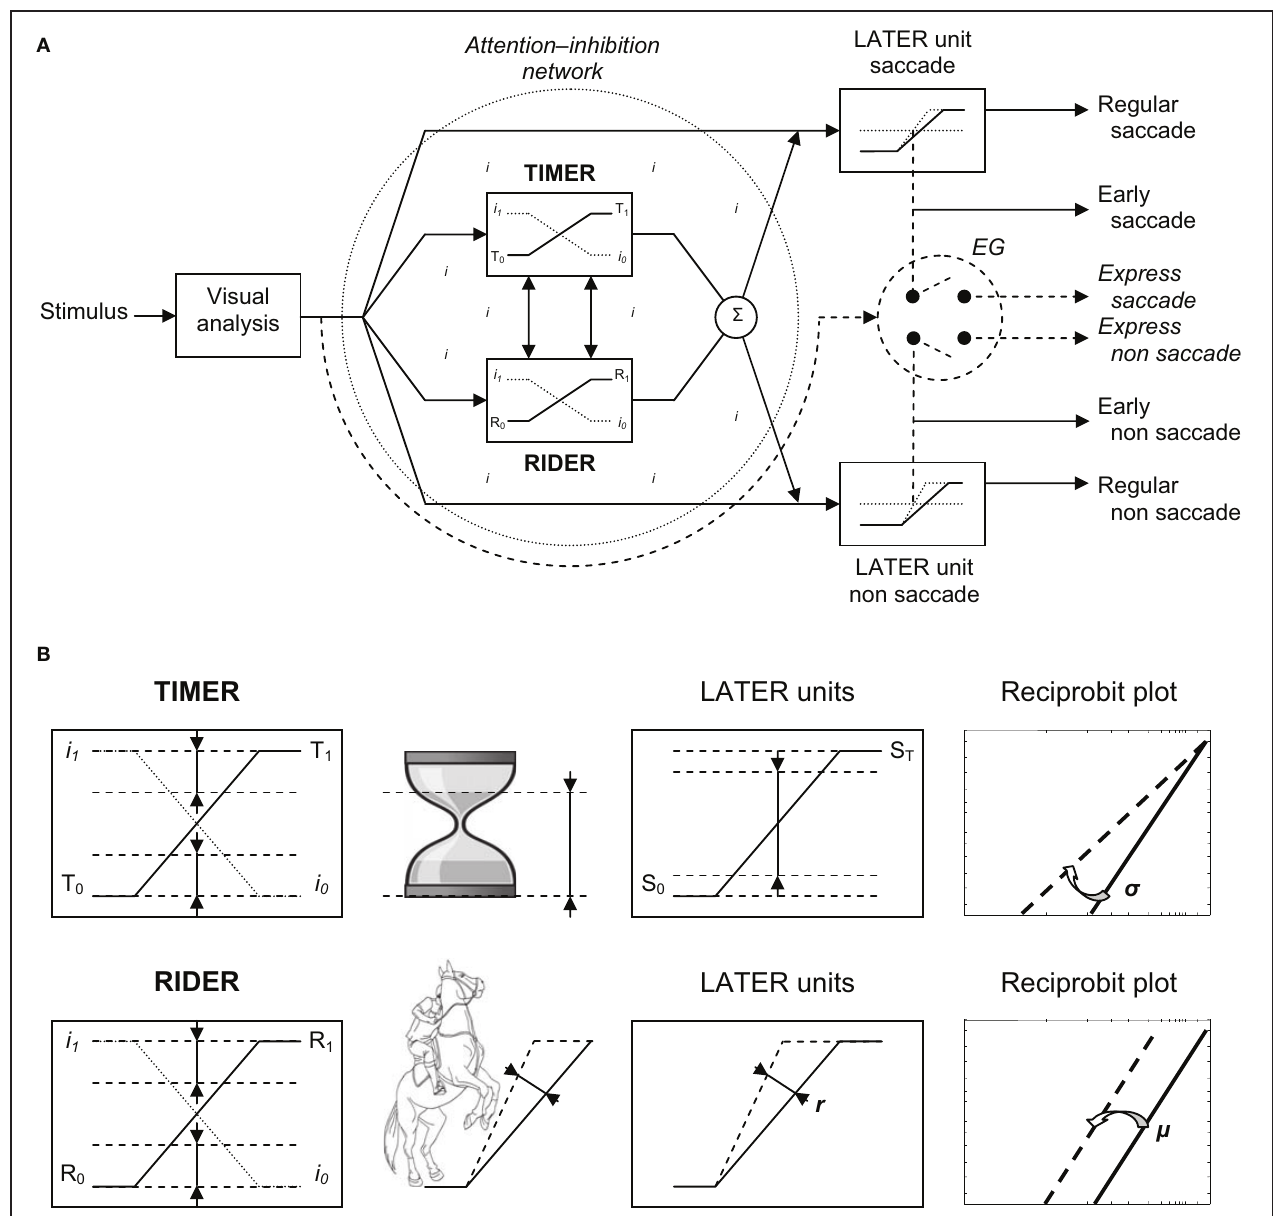
FIGURE 6 | (A) TIMER-RIDER model. Visual information from the two retinas is analyzed to determine the location of the stimulus in space. Movement activation (right): For the decision to be made to elicit an eye movement toward the visual stimulus, decision signals initiate in LATER units for saccade and non-saccade, which rise at a constant rate to reach the threshold at which regular or early saccade and/or non-saccade are triggered. In LATER units, the thresholds and/or the rates of rise for saccade and non-saccade can differ. Movement inhibition (dotted circle): In a global attention-inhibition network, the inhibition process has value between I 1 and I 0 throughout the network. Two units modulate movement inhibition: TIMER (Threshold Interval Modulation with Early Release) and RIDER (Rate of rIse Deviation with Early Release). TIMER and RIDER signals increase from, respectively, values T 0 and R 0 to values T 1 and R 1 (full line), causing a mirror decrease in inhibition from I 1 to I 0 (dotted line). Modulators’ effects are added ( (cid:2) ) producing a change in LATER units in either decision thresholds or